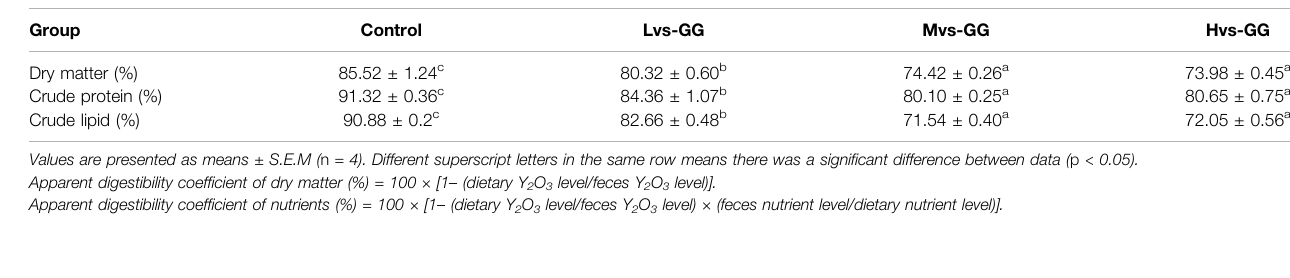
TABLE 6 | Effects of different viscous guar gum on intestinal digestive and absorptive enzyme activities.